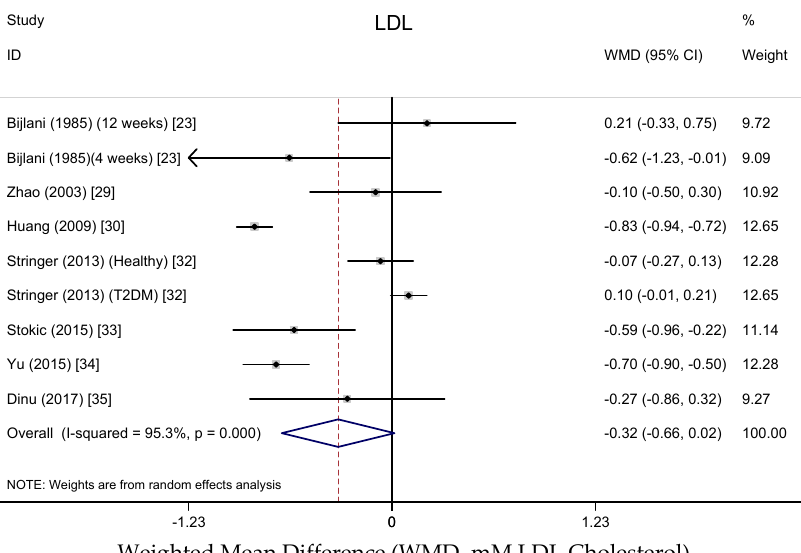
Figure 3. Meta-analysis of the effects of buckwheat products intake on blood total cholesterol concentration compared with baseline or control groups for human studies. Sizes of data markers indicate the weight of each study in the analysis. WMD, weighted mean difference (the results were gained from a random-effects model). Negative values favor a reduction in blood total cholesterol with buckwheat consumption; the dashed line shows the overall WMD value and the size of the rhombus the cumulative effect size and CI.